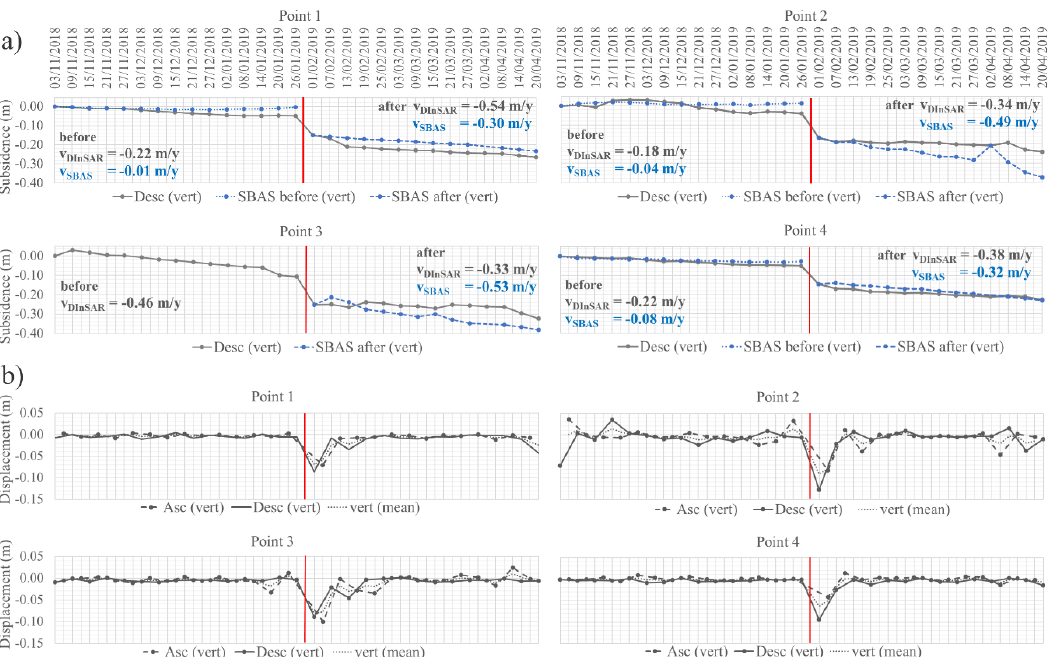
Figure 6. Time-series for selected points (Figures 4 and 5), showing: ( a ) the vertical subsidence for the period three months before and three months after the earthquake (red line), extracted from the descending SBAS (dashed blue lines) and DInSAR (solid black line); ( b ) the vertical displacement for the same period, extracted from ascending (dashed line) and descending (solid line) DInSAR data. The dotted line represents the mean value of the vertical displacements.